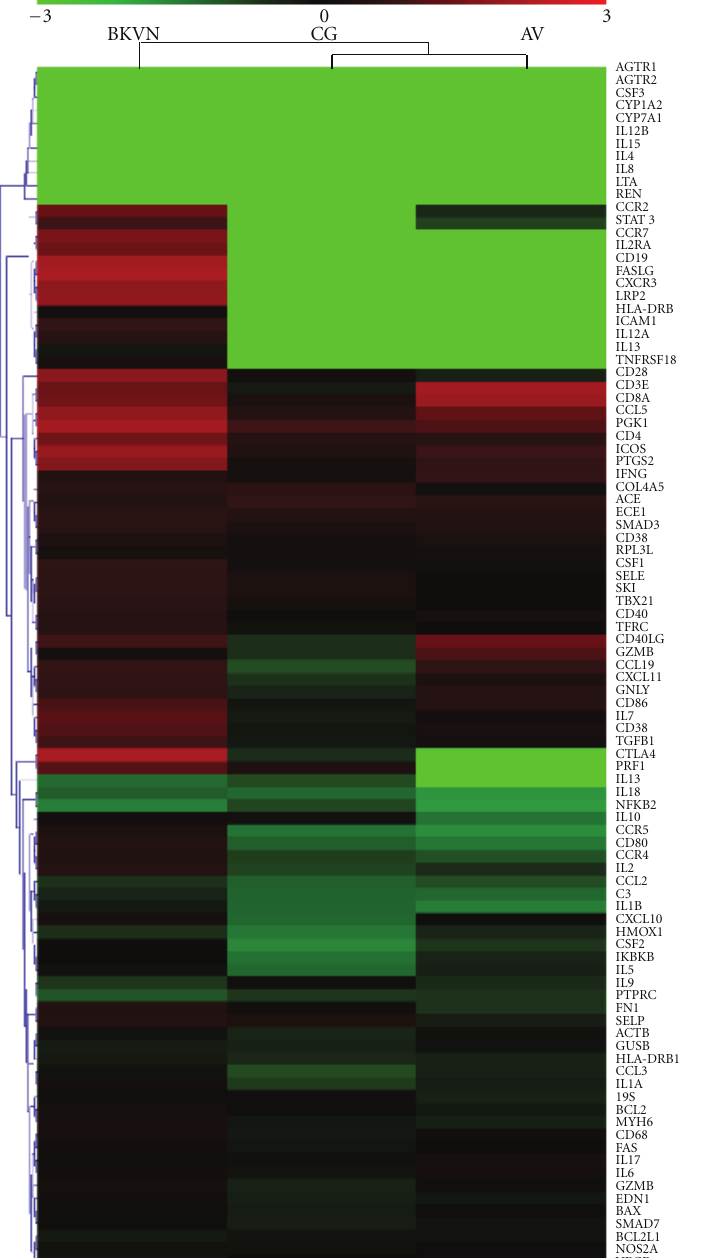
Figure 1: Hierarchical clustering of 3 studied groups. This heat map represents all 90 immune targets assayed (plus endogenous control). Medians of logarithmed relative quantification (RQ) values for each group were used to create the heat map. Red denotes genes with relative increased expression while green denotes genes with relative decreased